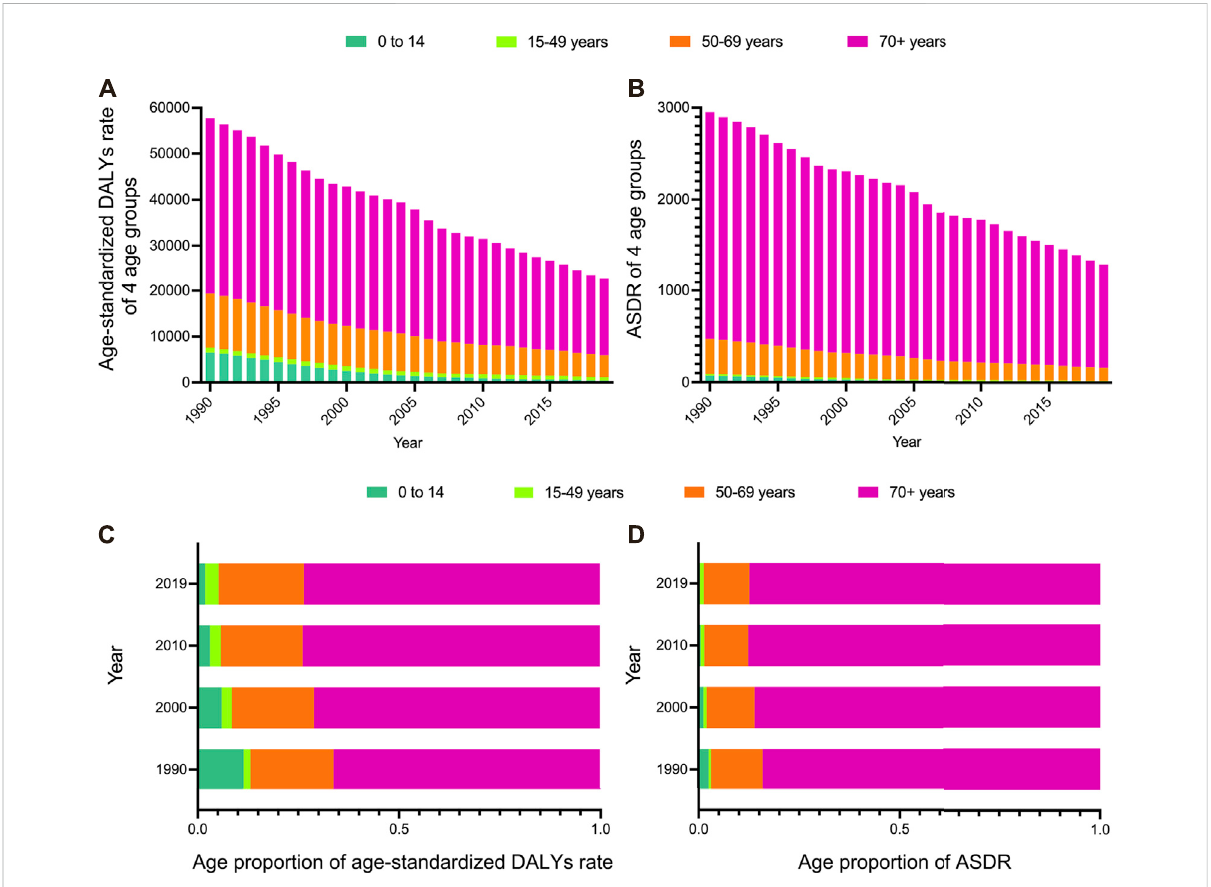
FIGURE 2 Age-standardized death and DALYs rate of different age groups due to air pollution in China from 1990 to 2019. (A) Age-standardized DALYs rateoffouragegroups from1990to2019. (B) ASDRoffouragegroupsfrom1990 to2019. (C) Four ageproportionsofage-standardizedDALYs rate in 1990, 2000, 2010, and 2019. (D) Four age proportions of the ASDR in 1990, 2000, 2010, and